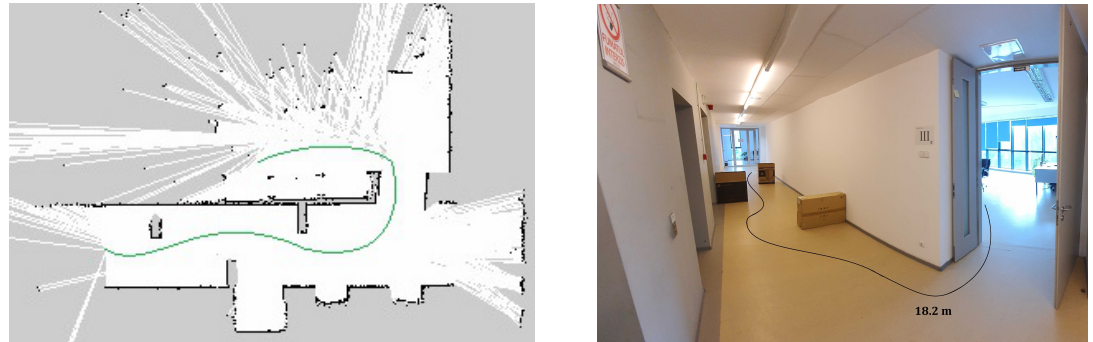
Figure 12. Navigation path on a larger scale experiment with obstacles placed on the